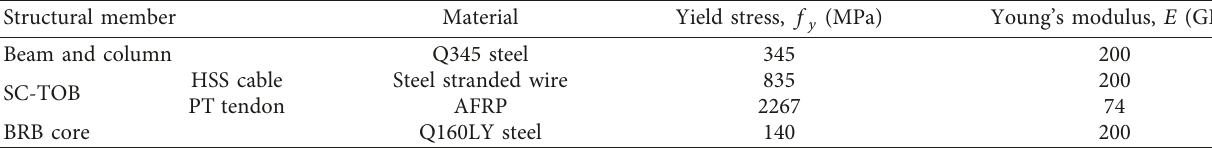
Table 7: Summary of selected material